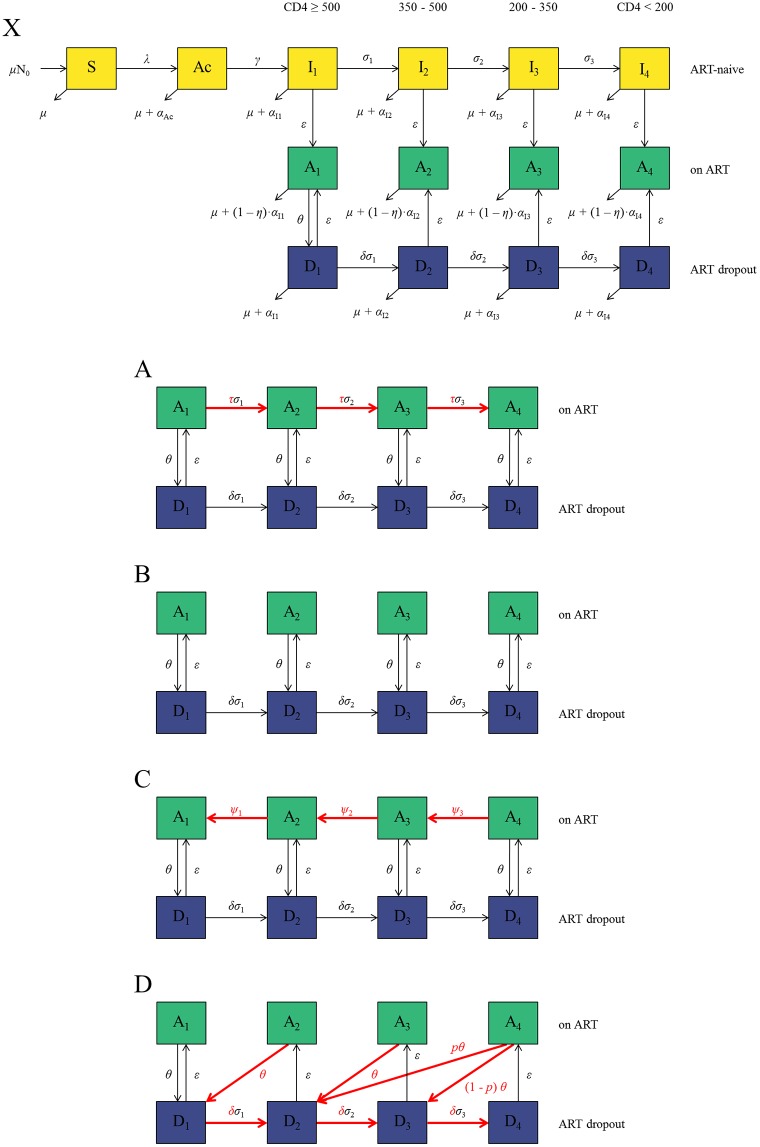
Model diagrams.X) General model structure showing only what is consistent across all progression assumptions, A, B, C, and D. The following model diagrams show only the ART compartments (Ai) and ART dropout compartments (Di) and do not show mortality. Key differences are highlighted in red. A)
Progression assumption A: ART reduces disease progression rate (σi) by a factor τ while ART dropouts progress at the same rate as ART-naive individuals (δ = 1). B)
Progression assumption B: There is no movement between ART compartments; prognosis depends on CD4 at ART initiation. C)
Progression assumption C: ART patients progress to higher CD4 categories over time at a per-capita rate ψi and the rest is as in progression assumption A. D)
Progression assumption D: As in assumption B, there is no movement between ART compartments. However, upon dropping out of ART, individuals move to a higher CD4 category (reflecting improvement in CD4 count on ART) but then progress at an increased rate compared to ART-naive individuals (δ>1; reflecting the rapid CD4 decline which occurs after dropping out of ART).